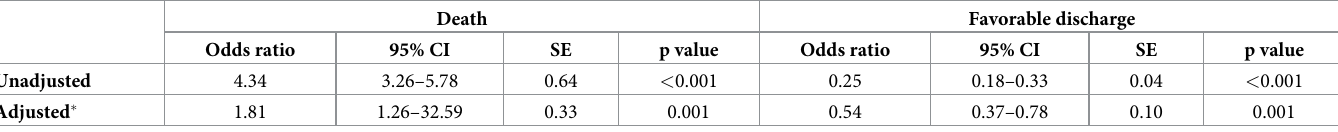
Table 4. Mixed-effects logistic regression fit to in-hospital death and favorable discharge, showing odds ratios for SAH patients with comorbid COVID-19 com- pared with